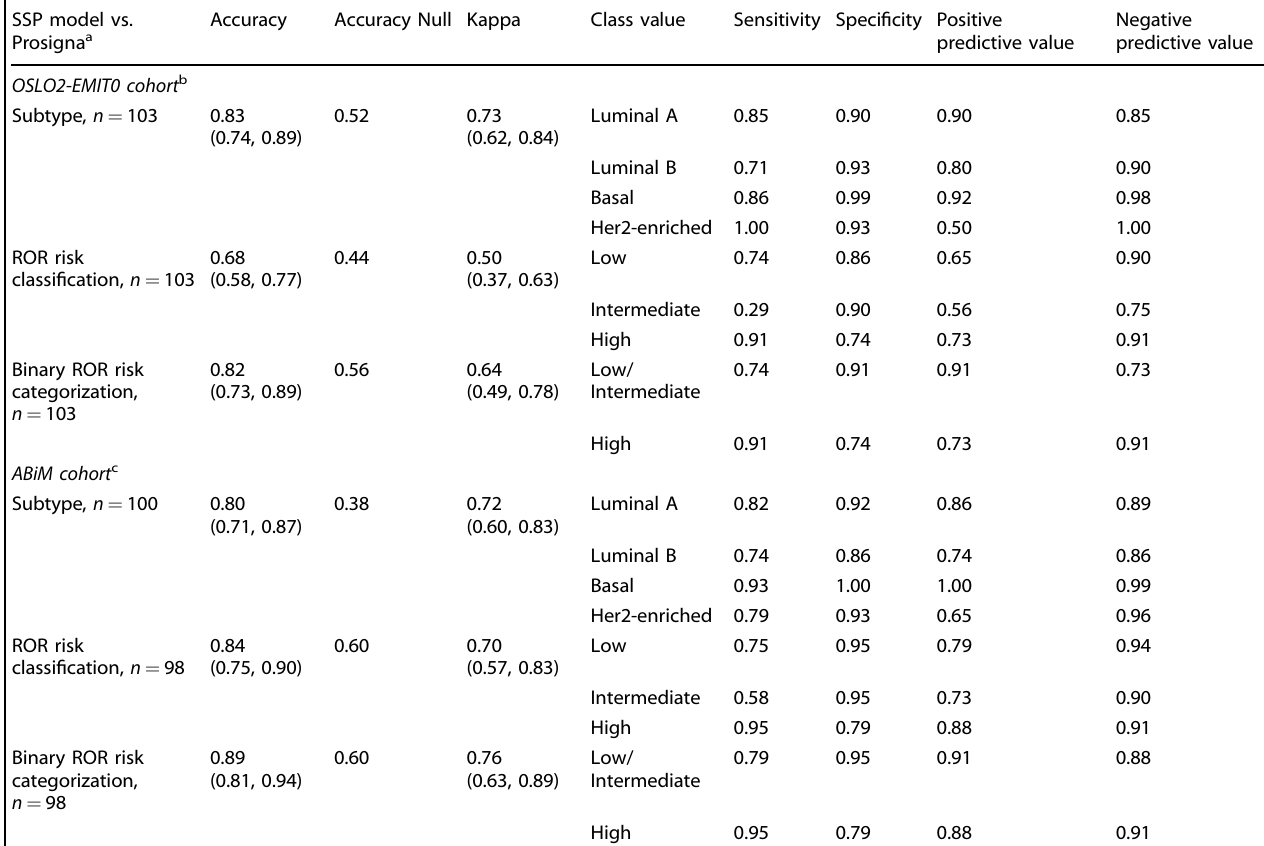
Table 4. SSP prediction performance validated against Prosigna classi fi cation in the full external clinical series OSLO2-EMIT0 and ABiM. SSP model vs. Prosigna